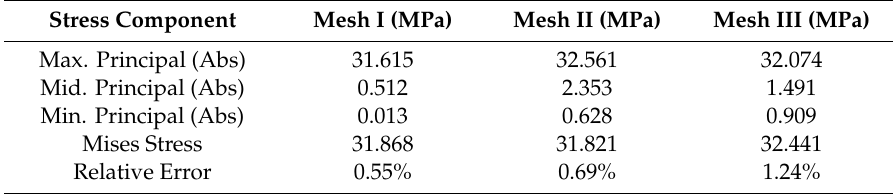
Table 7. Stress statistics and relative error for different meshes on KP2.